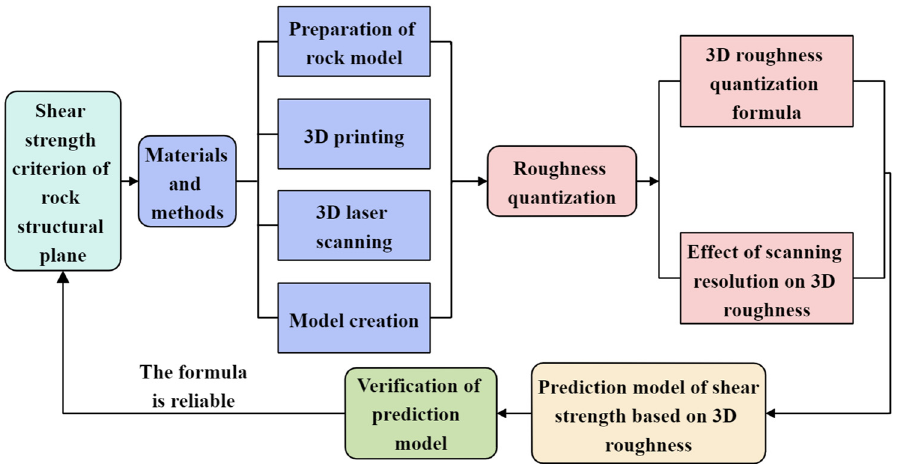
Figure 1: Flow chart of shear strength research of rock structural plane.